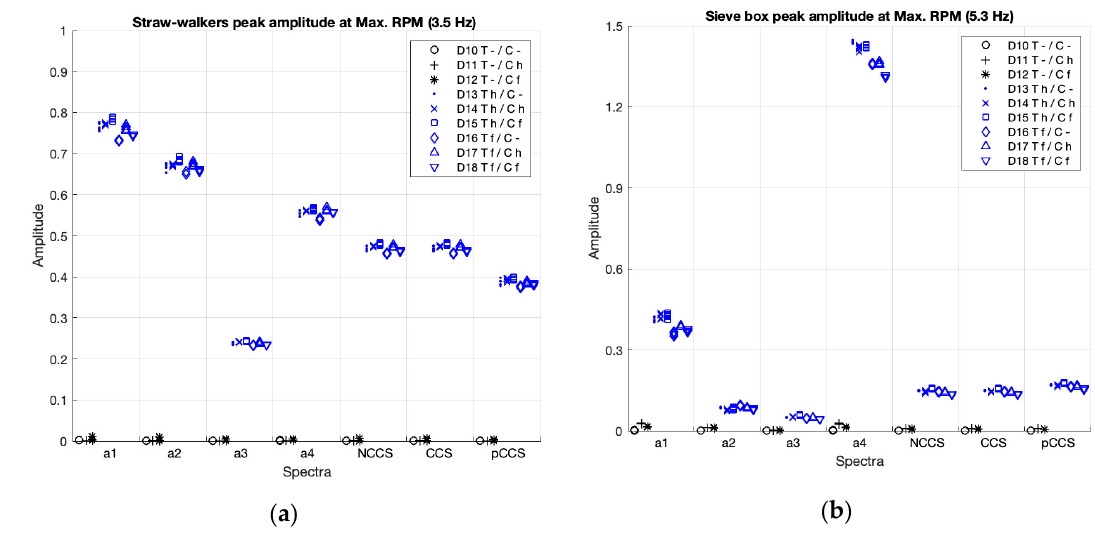
( a ) ( b ) Figure 10. Peak amplitudes of the sieve box in the individual spectra (a1–4) and the non-coherent (nCCS), coherent (CCS), and poly-coherent (pCCS) composite spectra, at idle ( a ), and at maximum RPM ( b ). The balanced cases are shown in blue and the deactivated components are shown in black. Table 6. Sample description and statistical comparison of the peak amplitudes of the sieve box in the individual spectra (a1–4) and the non-coherent (nCCS), coherent (CCS), and poly-coherent (pCCS) composite spectra, under different working conditions (deactivated, activated) and speeds (at idle and at max. RPM). Deactivated Activated Activated vs. Deactivated Table 7. Magnitudes (e ff ect sizes) of the capacity to di ff erentiate the status (deactivated, activated or unbalanced) of the components of a combine harvester functioning at two speeds (idle and maximum RPM) in the four individual spectra (a1–4) and in the non-coherent (nCCS), coherent (CCS), and poly-coherent (pCCS) composite spectra. Thresher Chopper Straw Walkers Sieve Box Balanced vs. Unbalanced vs. Balanced vs. O ff Unbalanced vs. Balanced vs. Balanced vs. Deactivated Balanced Status Balanced Deactivated